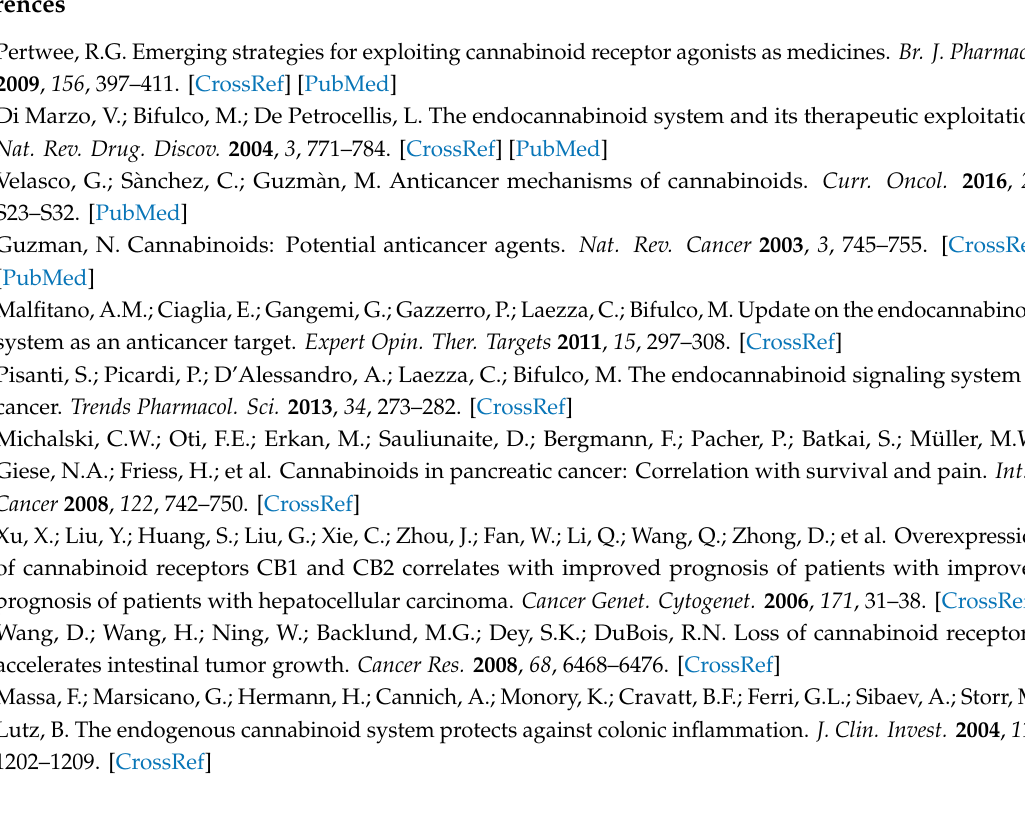
Figure S1: All Western blot figures include a dot plots graph showing the densitometry values of each sample (band) normalized to β -actin